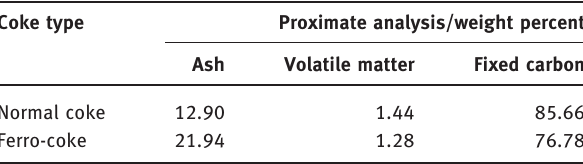
Table 1: Proximate analysis of the normal coke and ferro-coke mass %.